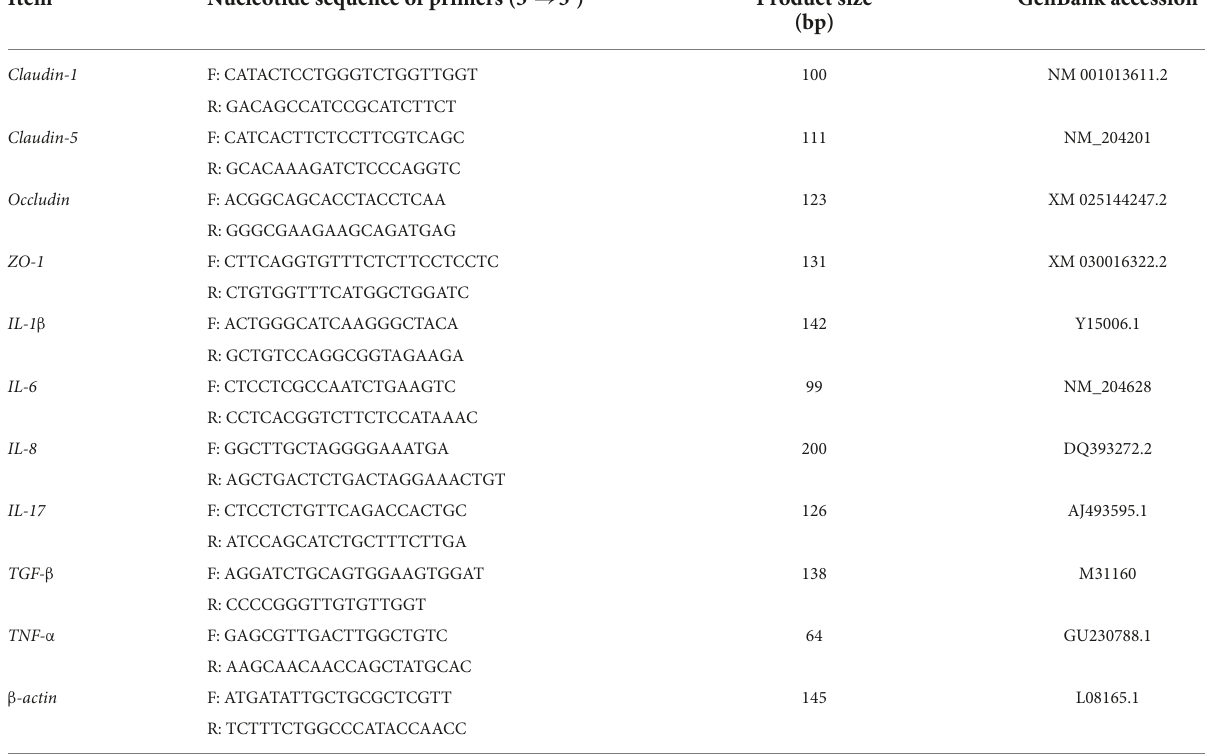
TABLE 2 Sequence, product size and accession number of primers for quantitative real-time